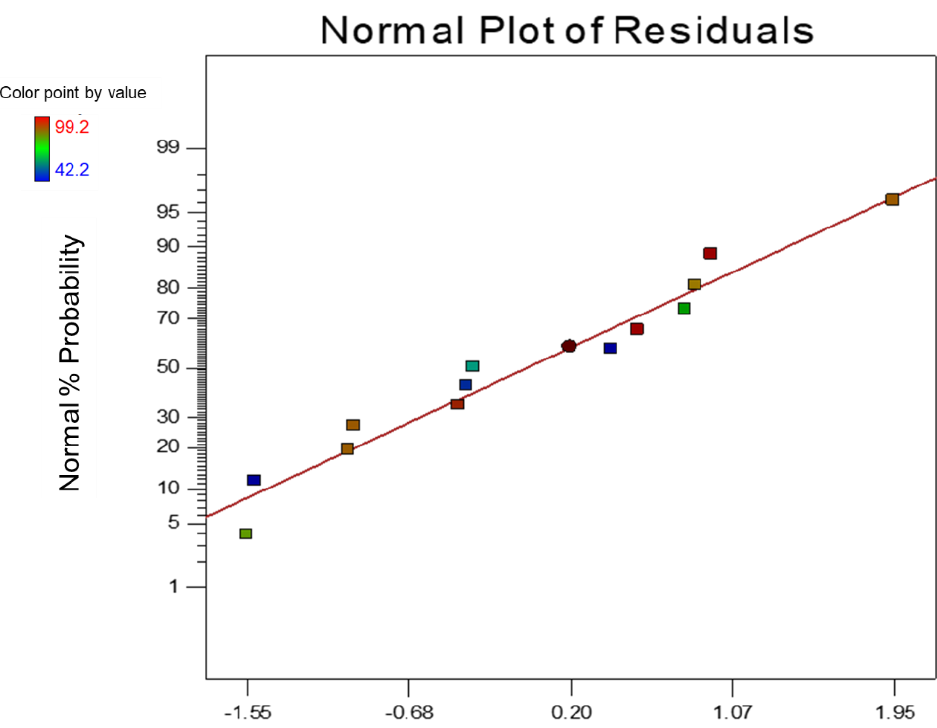
Figure 12. Normal Probability Plot of Oil Contact Angle Optimisation.